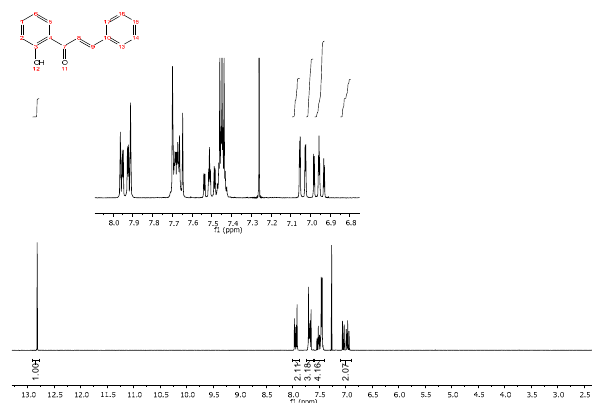
Figure 4. 1 H NMR spectrum of the 2’-hydroxychalcone 3a.